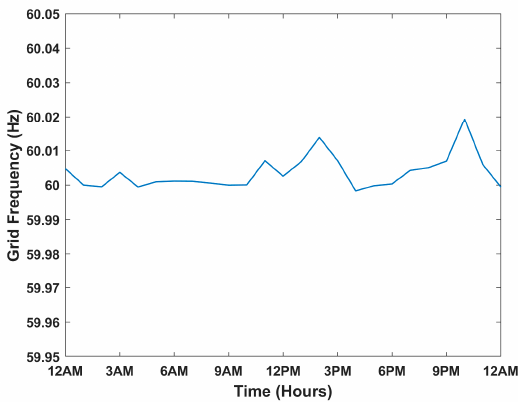
Figure 15. Models validation against actual demand. ( a ) “Base case: no pricing used in inputs” L ‐ ARX regression model; ( b ) One ‐ step L ‐ ARX regression model; ( c ) Two ‐ step L ‐ ARX regression model; ( d ) One ‐ step N ‐ ARX regression model; ( e ) Two ‐ step N ‐ ARX regression model; ( f ) “Base case: No pricing